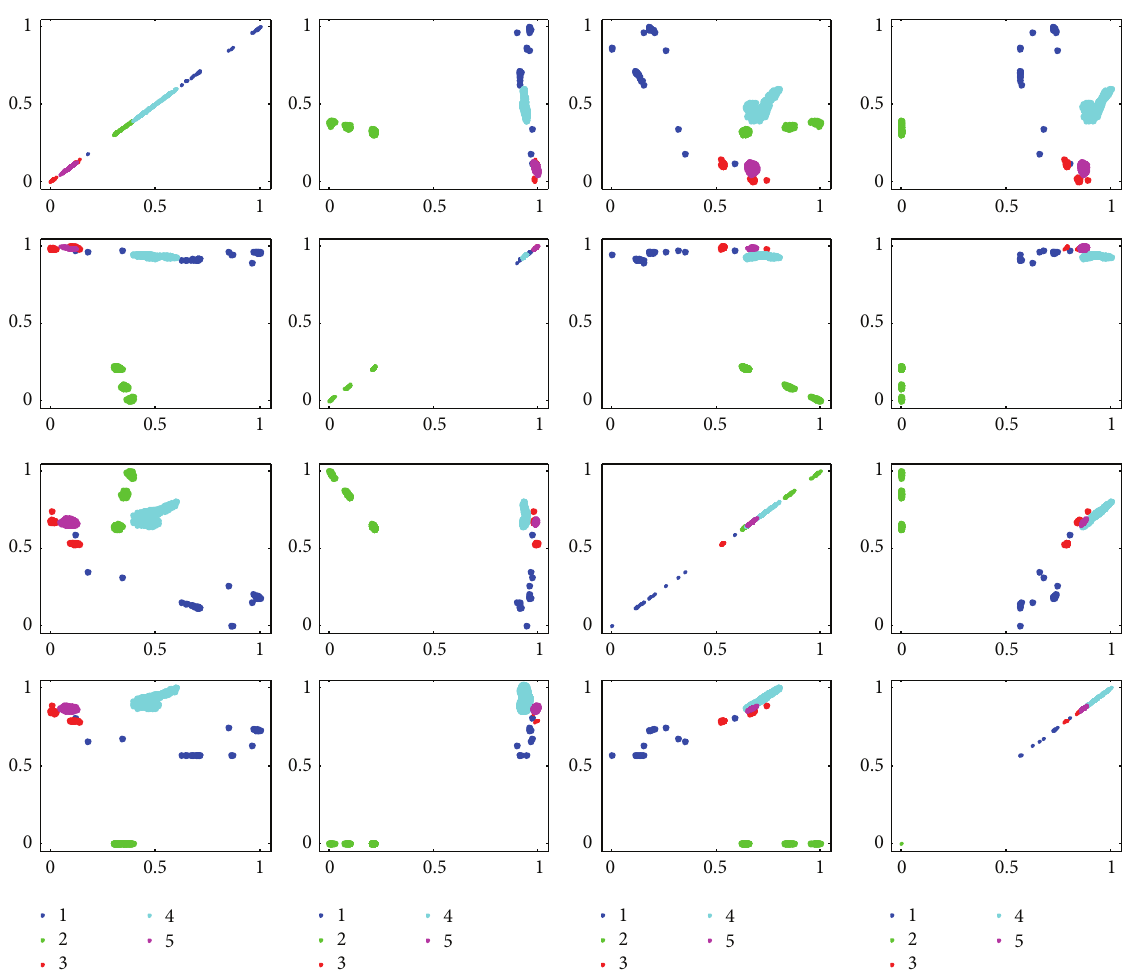
Figure 16: Scatter in 2D space expended with feature pairs selected by Shannon mutual information.